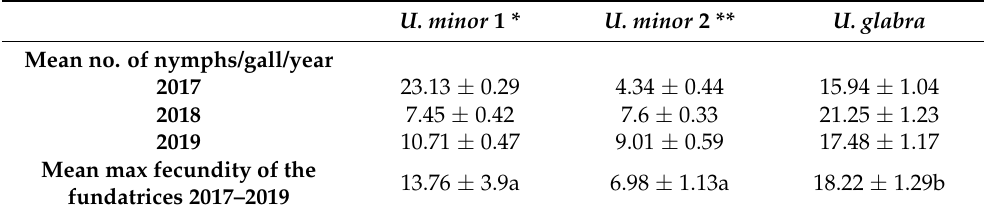
Table 4. Maximum fecundity of T. nigriabdominalis fundatrices, gall widths and heights in U. minor and U. glabra in 2017–2019 (mean ± SE (standard error); values marked with different letters differ significantly at p < 0.05 for each parameter (Kruskal–Wallis